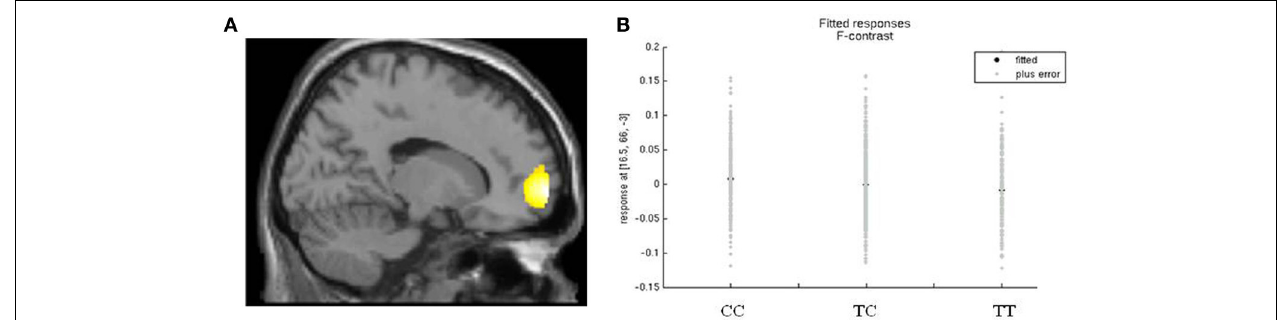
FIGURE 2 | rs17137124 and white matter density in the frontal lobe. (A) Relationship between white matter volume in the frontal lobe and variation in rs17137124, at x = 16. (B) Direction of the effect of rs17137124 at